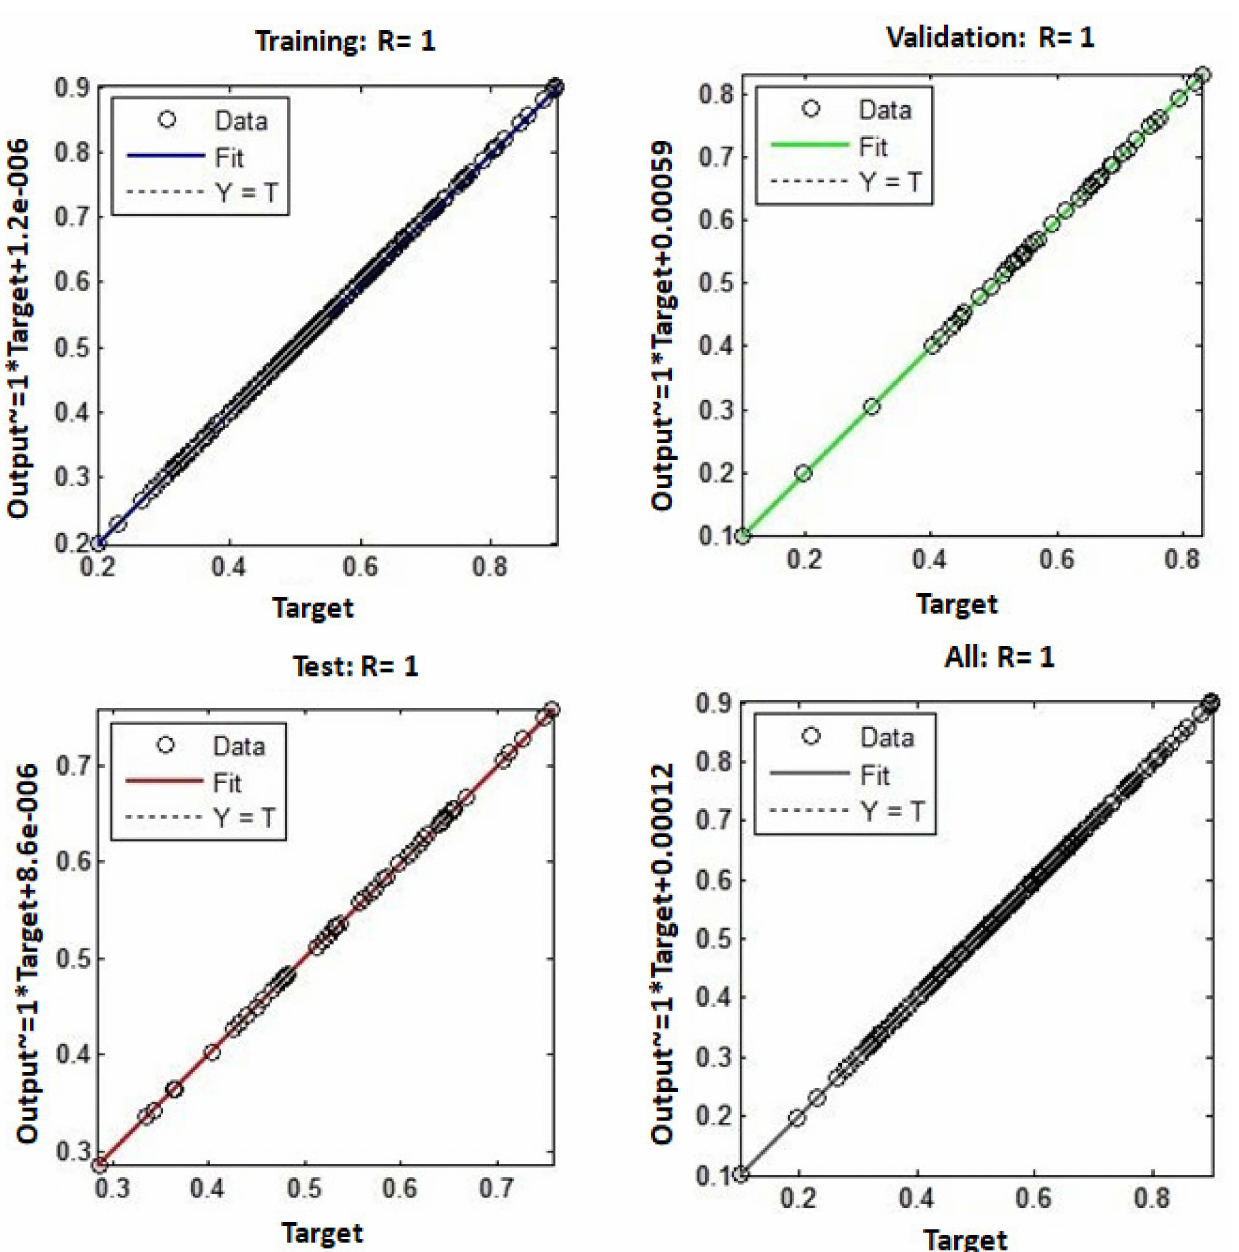
Figure 26. Regression graph of network 4-9-3 for angular distortion with time gap between two, three and four